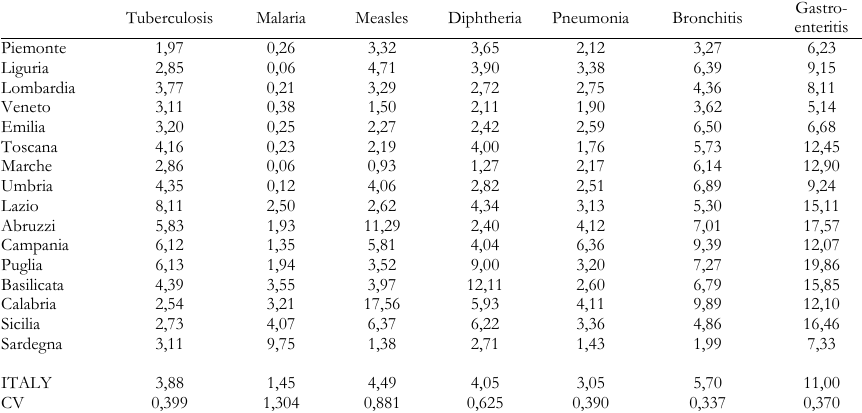
Age and cause specific child mortality rates (per thousand) in the Italian regions, 1888 Tuberculosis Malaria Measles Diphtheria Pneumonia Bronchitis Gastro- enteritis Piemonte